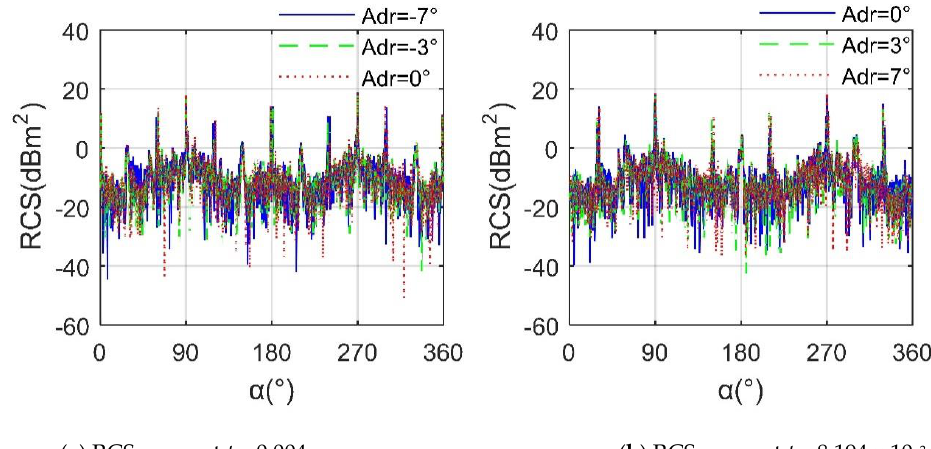
Figure 13. RCS of helicopter at various A dr , f RH = 10 GHz, n r1 = n r2 = 1200 r/min, β = 0°, A df = 5°, γ = θ = 0°.